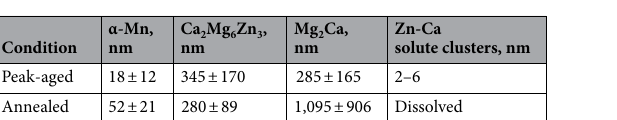
patterns (see SFigs. 2 and 3), during annealing at 400 ℃ for 1 h, Zn and Ca have diffused out from the 6H-layer structure, leaving behind I 1 -type SFs. Taken together, this work implies that the 6H structures were stabilized through Zn and Ca segregation to the I 1 -type SFs, which occurred during the thermo-mechanical steps involved in manufacturing this dilute alloy.